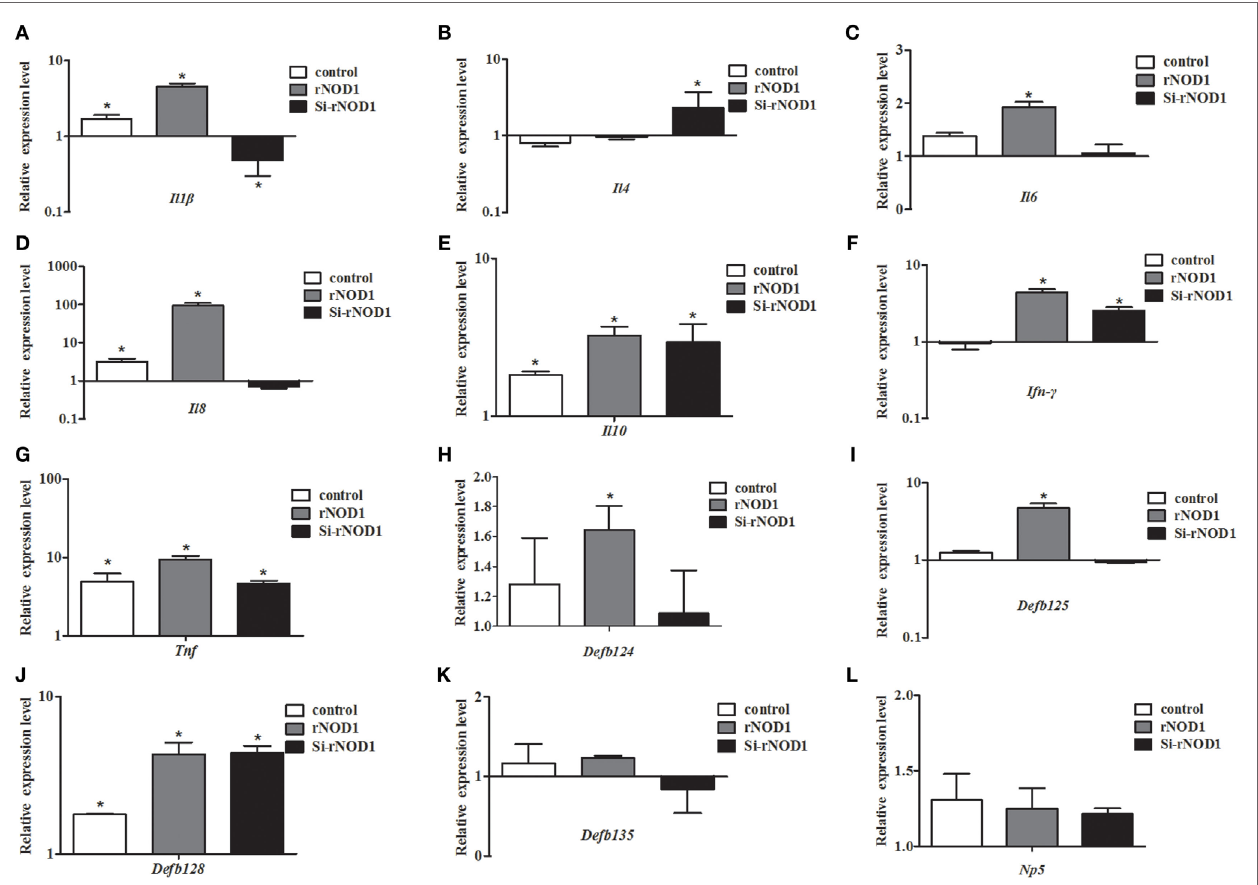
FigUre 6 | Effect of the overexpression or knockdown of rabbit nucleotide-binding oligomerization domain 1 (rNOD1) on expression of immune-related genes induced by Escherichia coli . Expression of (a) Il1b , (B) Il4 , (c) Il6 , (D) Il8 , (e) Il10 , (F) Ifn- γ , (g) Tnf , (h) Defb124 , (i) Defb125 , (J) Defb128 , (K) Defb135 , and (l) Np5 in E. coli- infected RK-13 cells transfected with pC-rNOD1 or si-rNOD1. M ± SD from three independent experiments are presented. Significant differences are indicated by *.